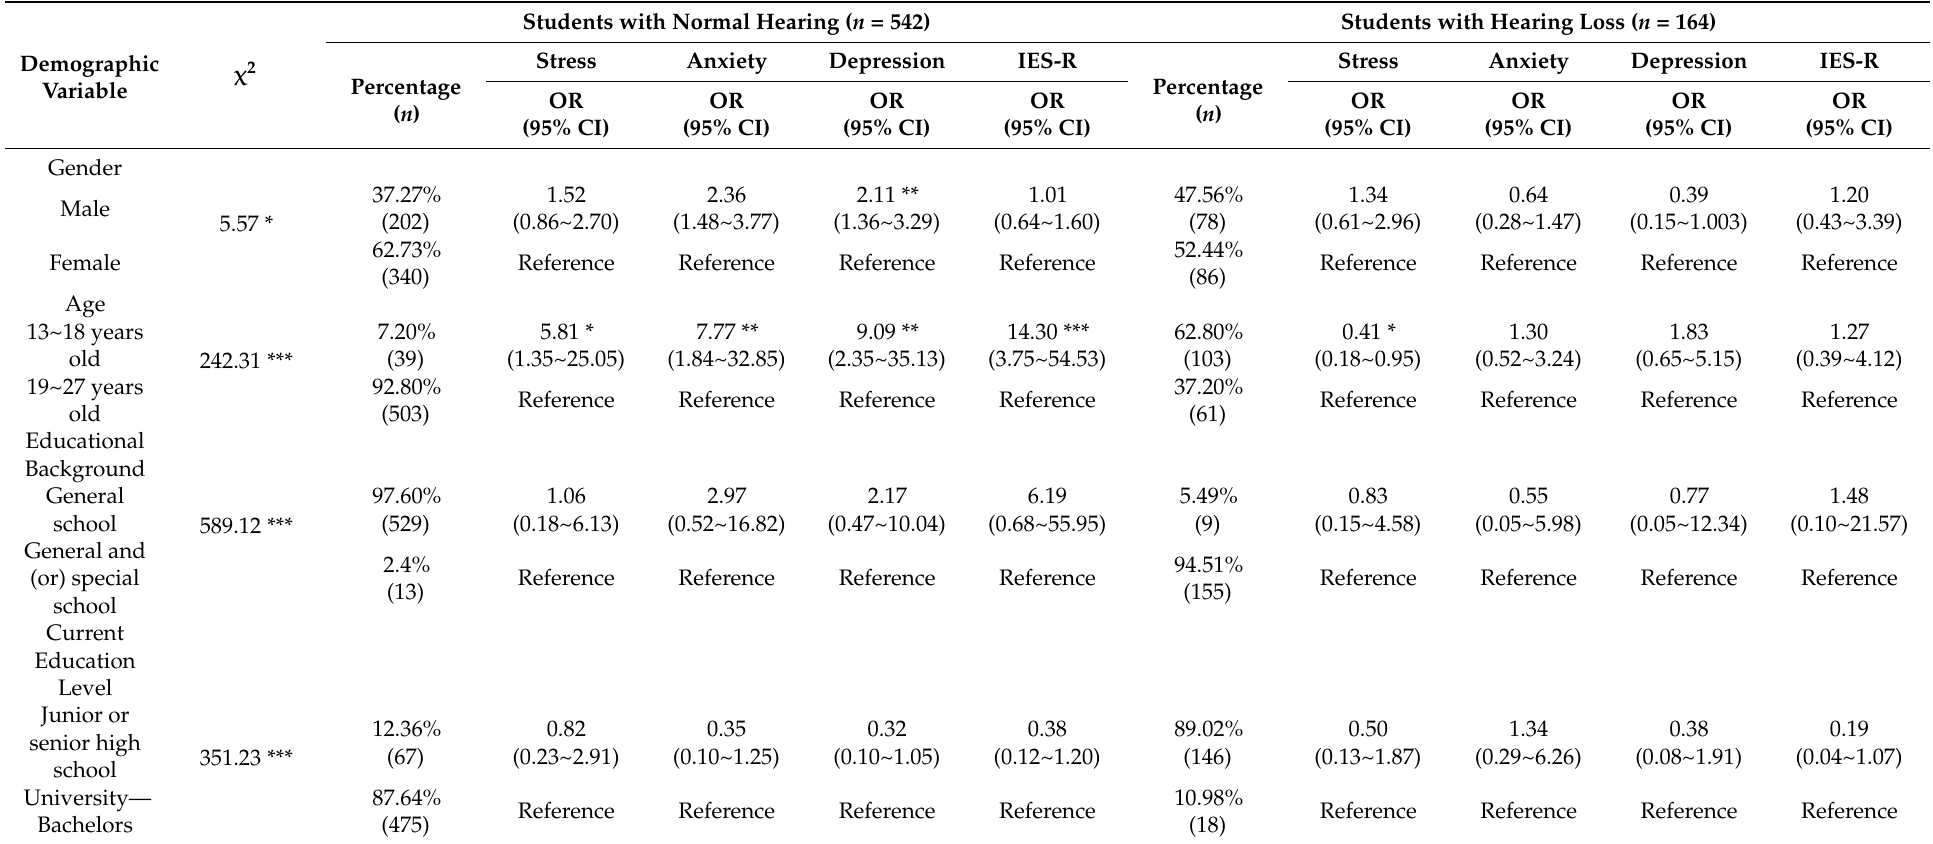
Table 1. Association of demographic variables with the mental health status and psychological impact for students with normal hearing ( n = 542) and students with hearing loss ( n =